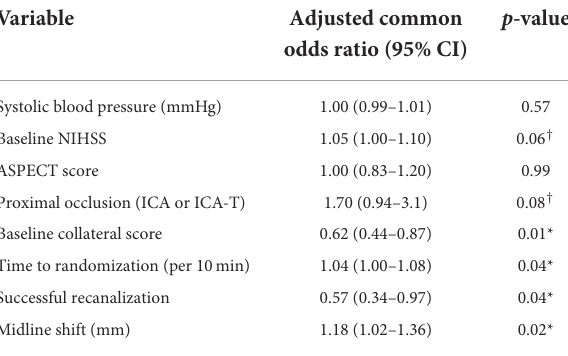
TABLE 2 Multivariable ordinal regression of subacute lesion evolution modeled in quartiles with baseline, imaging, and post-treatment